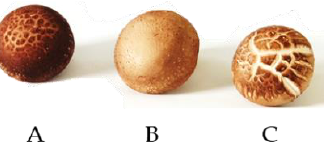
Figure 4. Photograph showing the ( A ) Shiitake, ( B ) HAS-5% and ( C )